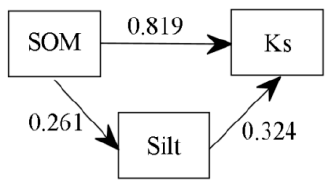
Figure 7. Path diagram for the relationship between K S and the main effective soil properties. The magnitude of the numerical values in the figure indicates the level of effects between the factors. Abbreviations: K S , saturated hydraulic conductivity; SOM, soil organic matter .